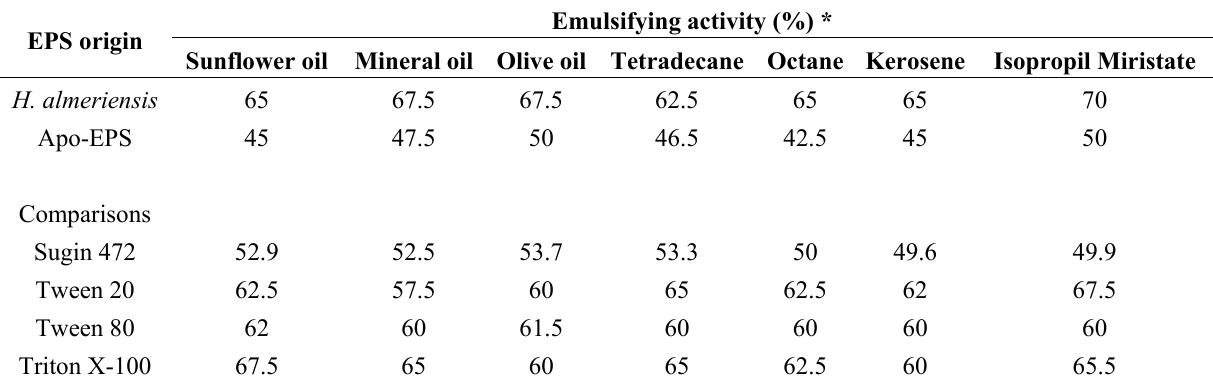
Table 2. Emulsifying activity of the EPS (fractions A and B) synthesised by H. almeriensis M8 T